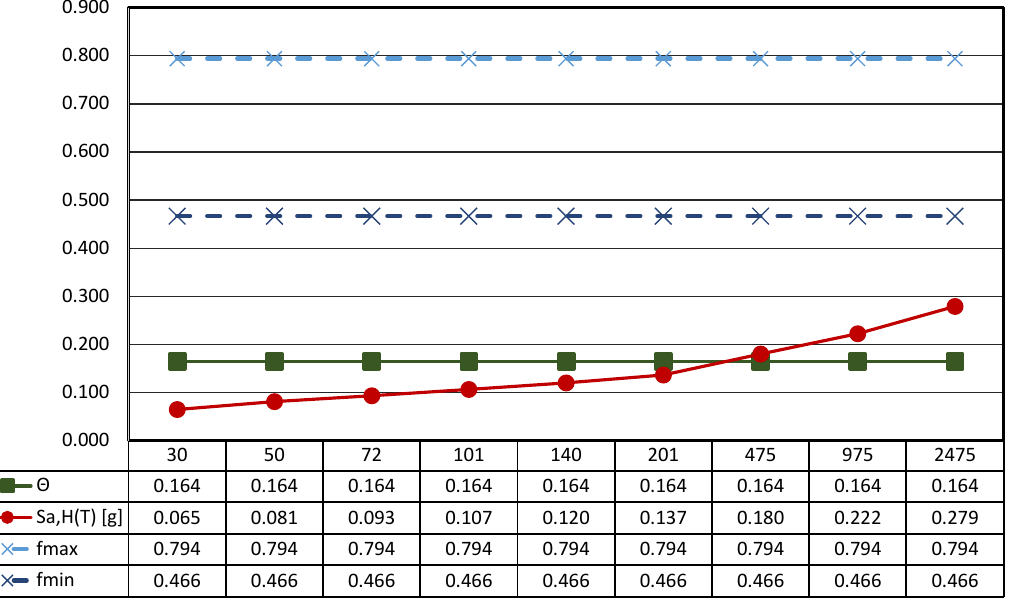
Figure 21. Results of the seismic performance assessment of the Resting Satyr under horizontal shaking only.